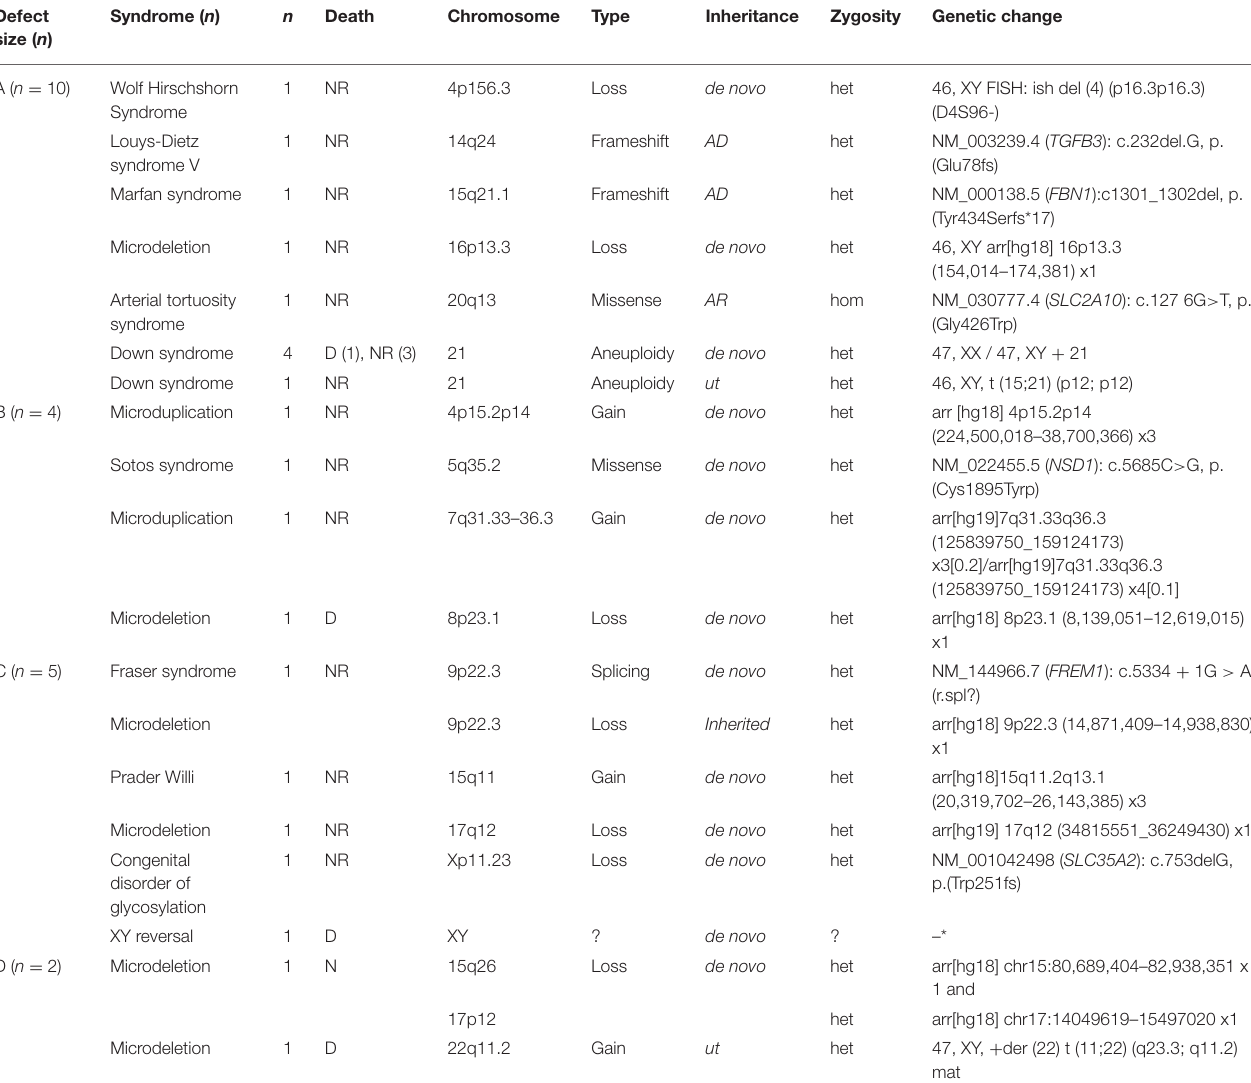
Type Inheritance Zygosity Genetic